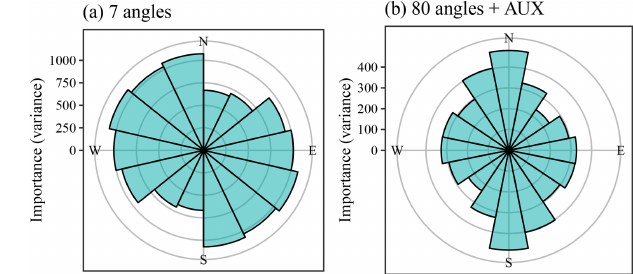
Figure 13. Covariate importance of the coordinate rasters at various angles for Vindum. (a) Importance of coordinate rasters at seven different angles. (b) Importance of coordinate rasters at 80 different angles used with auxiliary data (importance of auxiliary data not shown). The sizes of the bars show the importance of the coordinate rasters at a given angle. Bars in (b) show the sum of the importance of coordinate rasters aggregated into 0 . 125 π intervals.